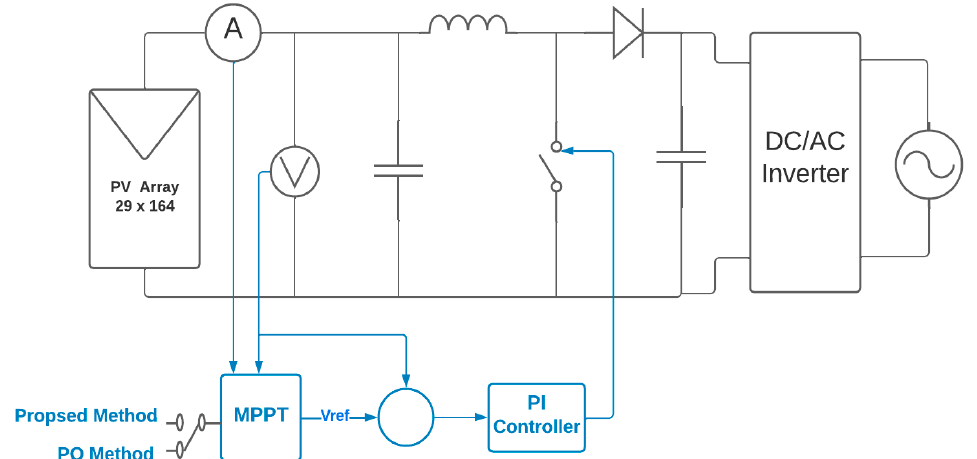
Figure 3. Schematic of the modeled grid-connected PV system in RTDS. Table 1. Grid-connected PV system